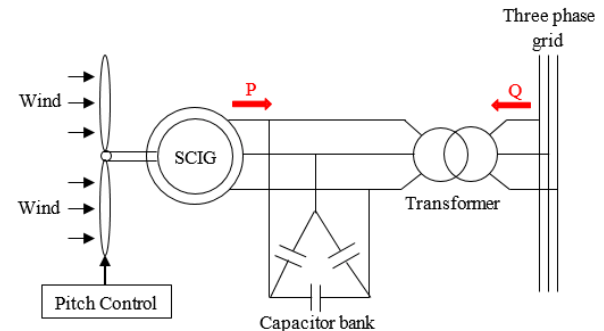
Figure 10. The fixed-speed wind turbine’s configuration.